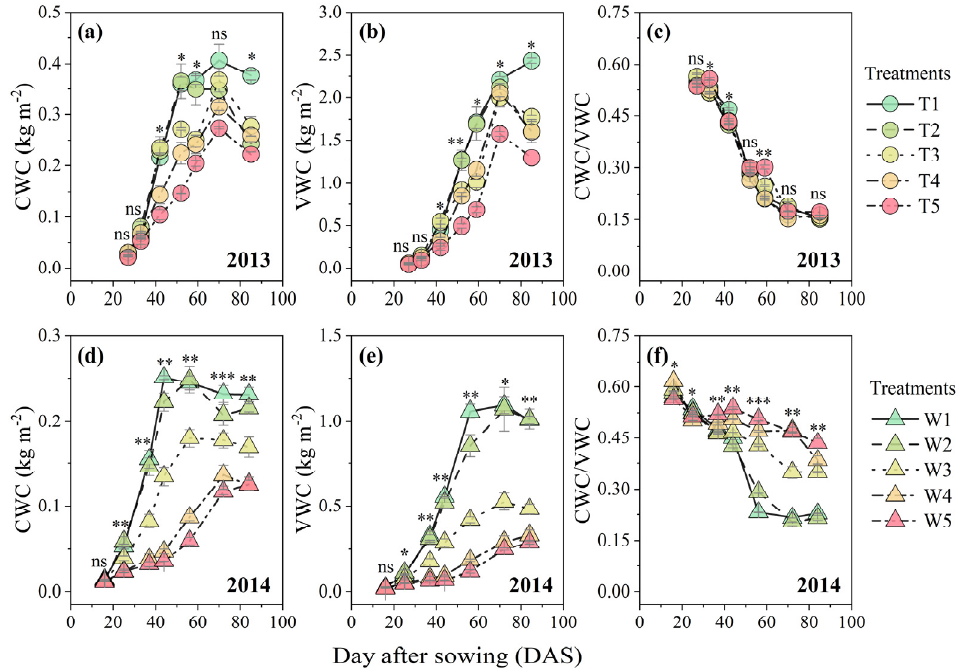
Figure 1. Changes in canopy water content (CWC), vegetation water content (VWC), and the ratio of CWC to VWC during soil drying under different irrigation treatments in the 2013 ( a – c ) and 2014 ( d – f ) growing seasons. ( a ) CWC in 2013, ( b ) VWC in 2013, ( c ) CWC/VWC in 2013; ( d ) CWC in 2014, ( e ) VWC in 2014, ( f ) CWC/VWC in 2014. The “***”, “**”, and “*” denote significant differences among treatments based on the analysis of variance (ANOVA) at p < 0.001, p < 0.01, and p < 0.05 levels, respectively, while “ns” indicates no significant differences. Error bars denote mean ± SE.